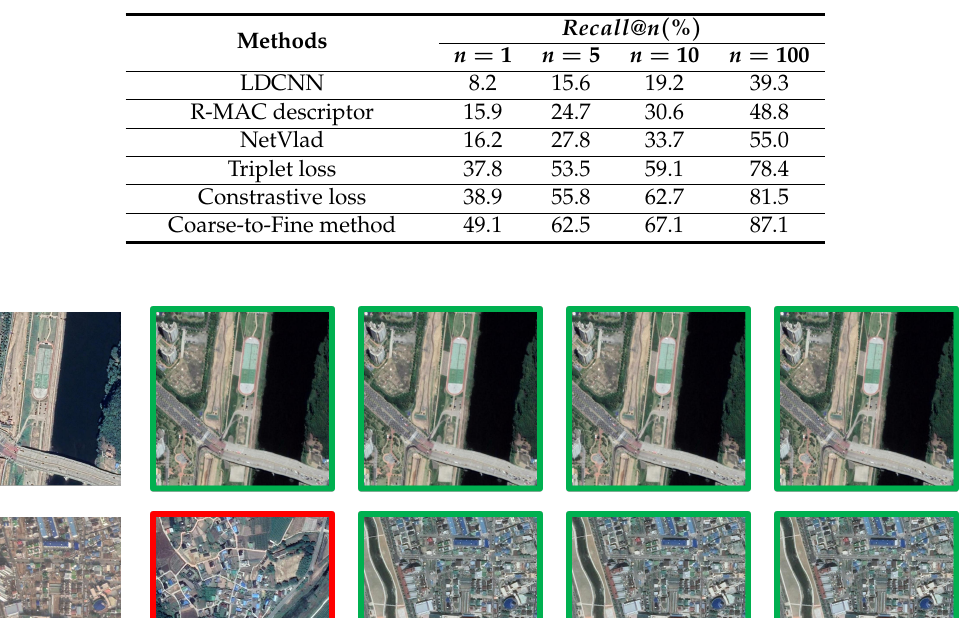
Table 5. Comparisions of retrieval result with state-of-the-art methods on the Google Earth South Korea dataset (Recall@n).